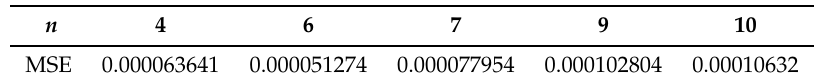
Table 16. n Selection for